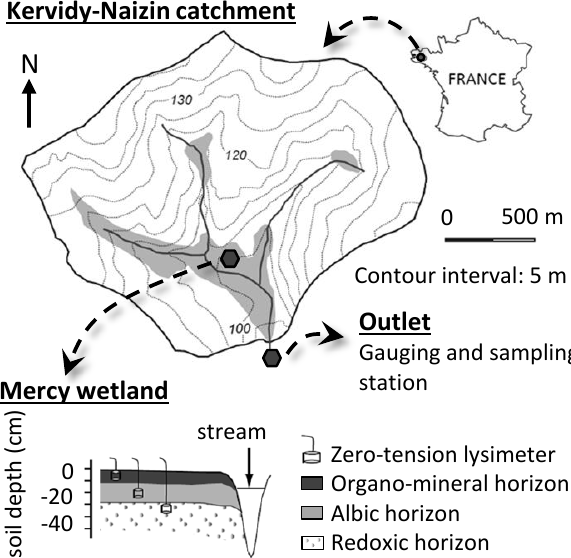
Figure 1. Map of the Kervidy–Naizin critical zone observatory (Brittany, France). Grey areas located along the channel network indicate the maximum extent of the wetland zones. Coordinates of the outlet are 48.0057 N, 2.8313 E (decimal